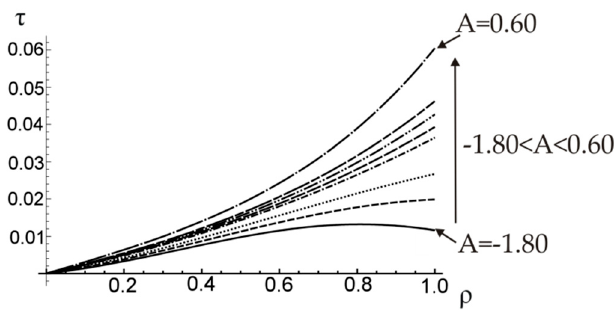
Figure 11. The distribution of shearing stress τ = τ / τ M